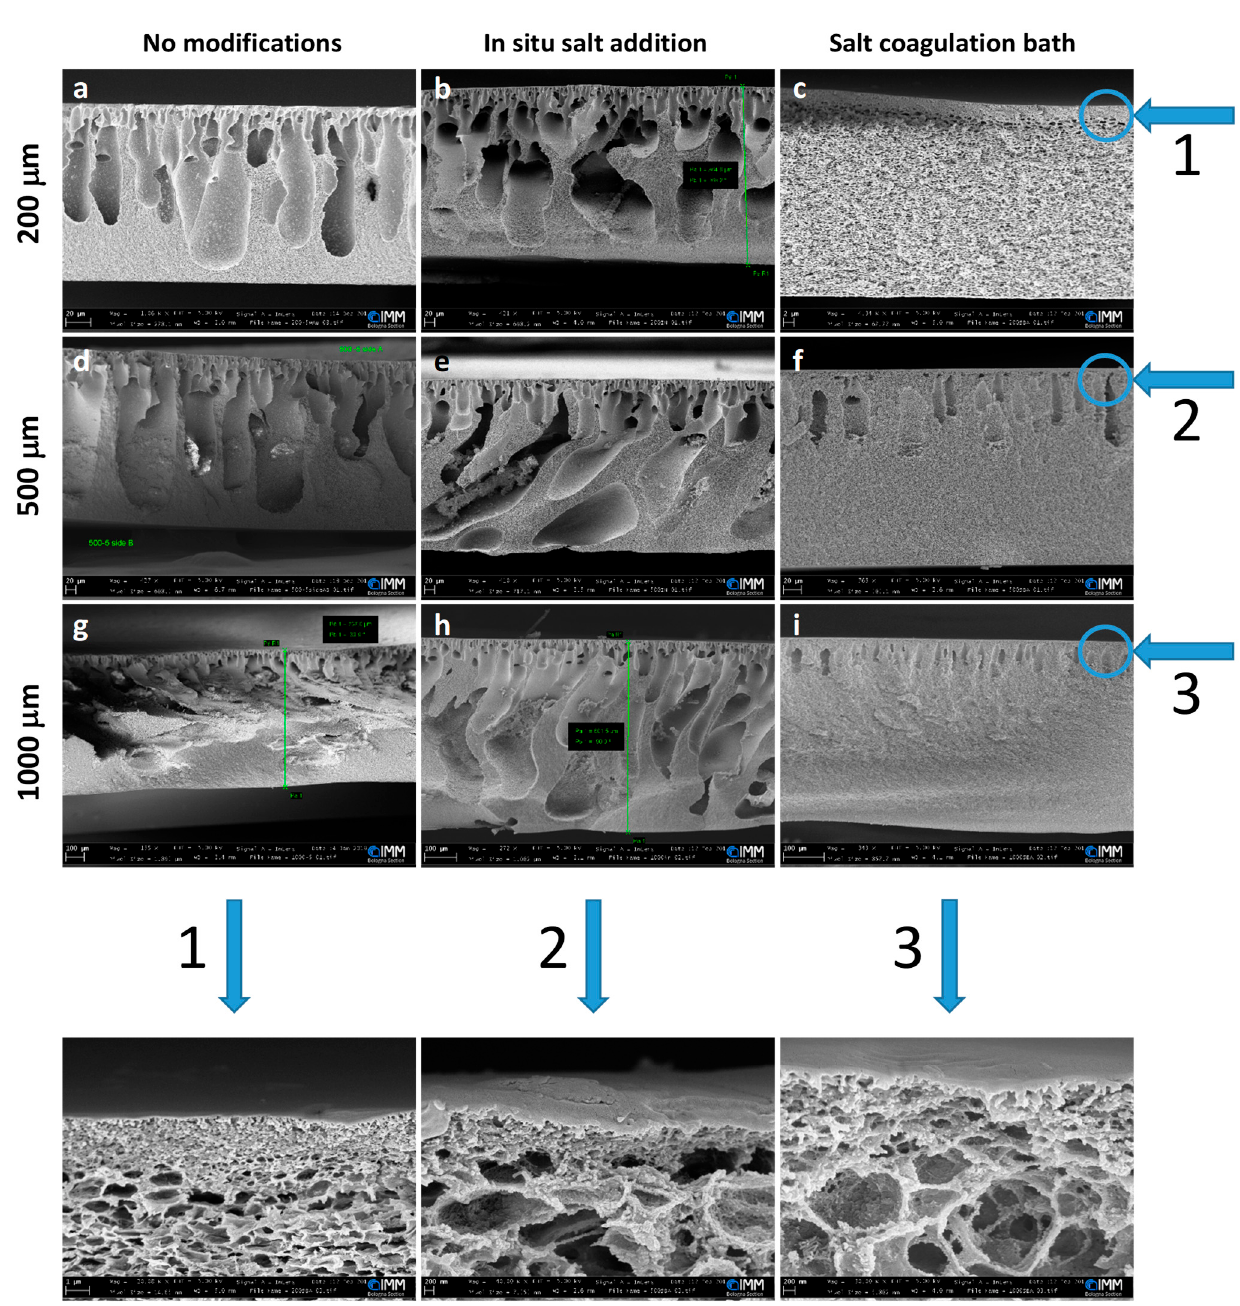
Figure 2. SEM images of the cross-section of CA membranes of different thicknesses without modification and using two different modifications: in situ salt addition and salt coagulation bath (film applicator speed = 5 mm/s). The scale bars are as follows: ( a , b , d – f ) 20 µm, ( c ) 2 µm, and ( g – i ) 100 µm. In the bottom line, magnifications of the images of the “salt coagulation bath” column are reported (scale bars: (1) 1 µm, (2) 200 nm, and (3) 200 nm).